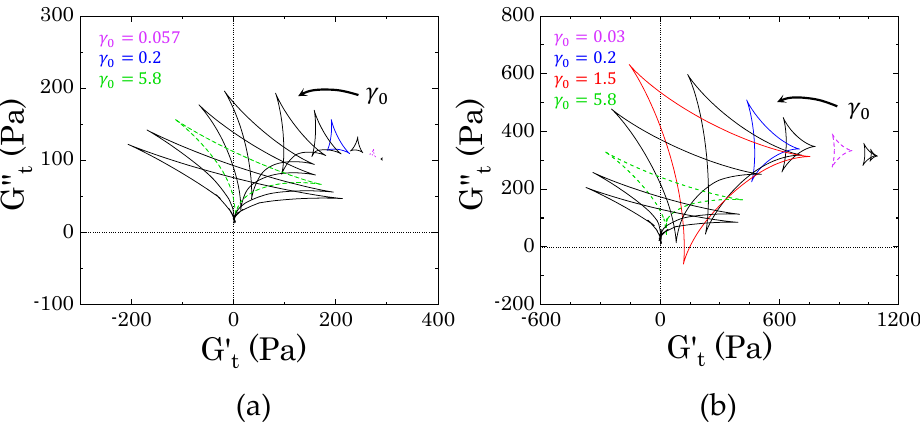
Figure 8. Evolution of the Cole–Cole plots at increasing strain amplitudes for two samples at 2% wt of Carbopol ( a ) in the absence of mannitol (sample M0) and ( b ) with mannitol in the presence of crystals (sample M2). All of the deltoids corresponding to the most relevant transitions observed in Figure 7a are marked with a specific colour. Dashed purple line: first point deviating from the linear viscoelastic plateau; blue solid line: peak of G (cid:48)(cid:48) ; red solid line: end of the first decay of G (cid:48)(cid:48) for sample M2; green dashed line: beginning of final strain-thinning